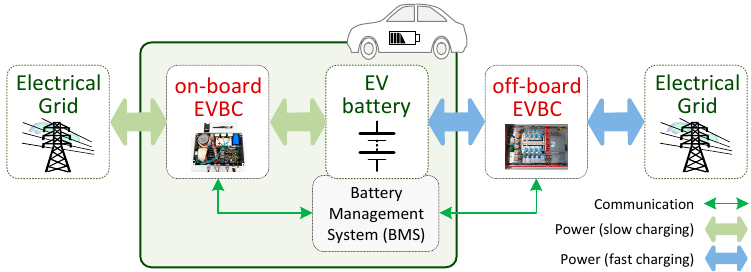
Figure 2. Interface of an EV with the power grid through an on-board EVBC and an off-board EVBC.